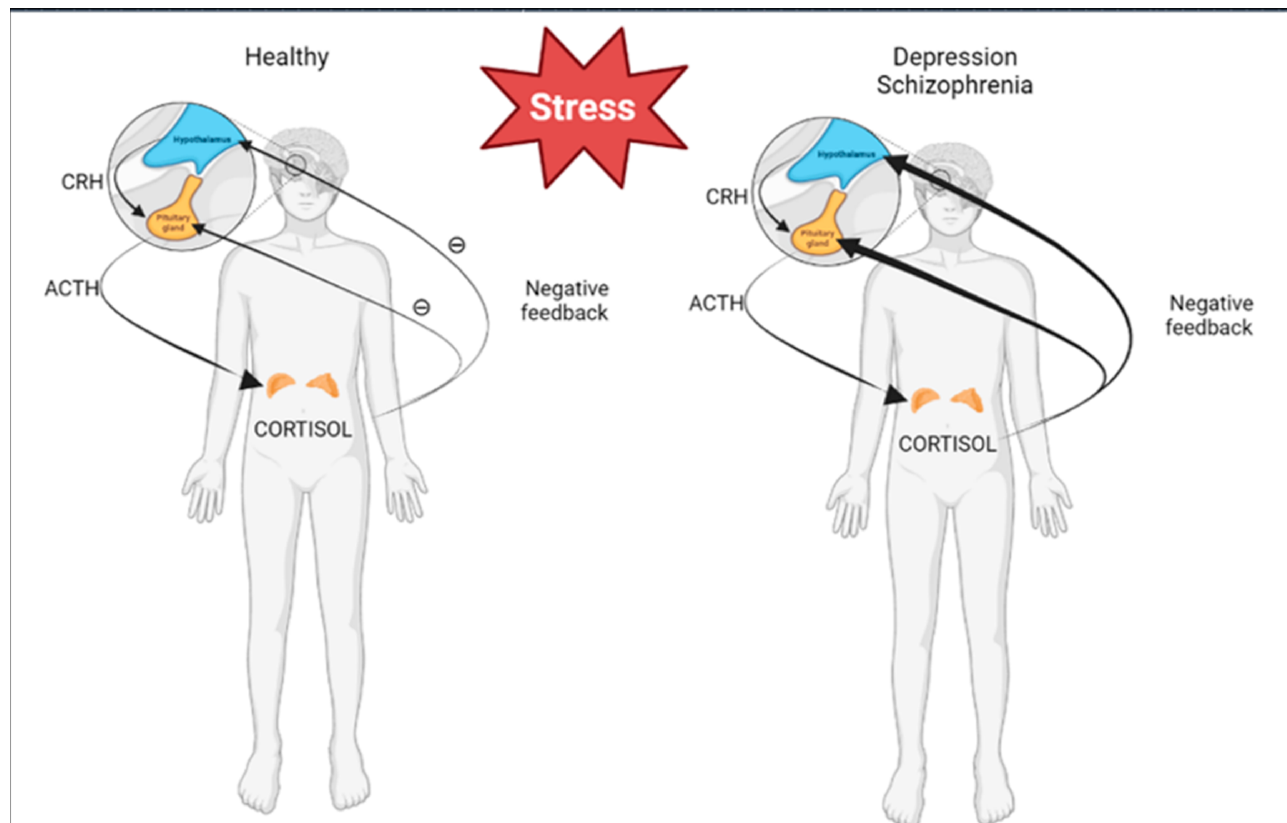
Figure 1. Differences in HPA axis activities of healthy patients and patients with depression or schizophrenia. This figure was created with BioRender.com.